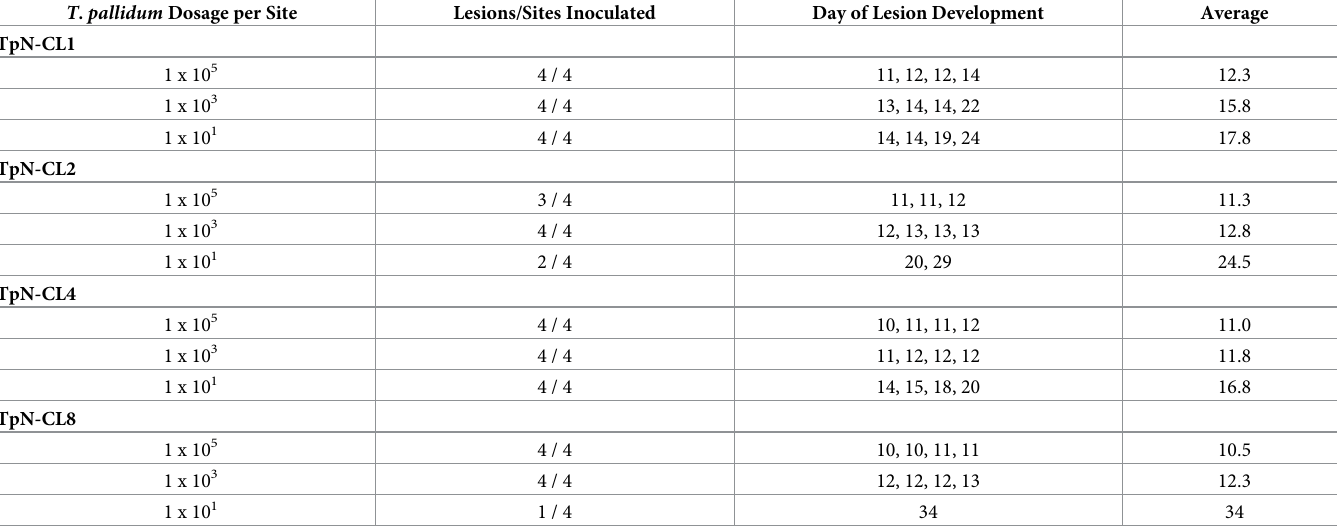
Table 1. Infectivity of T . pallidum Nichols clones in an intradermal infection rabbit model. T . pallidum Dosage per